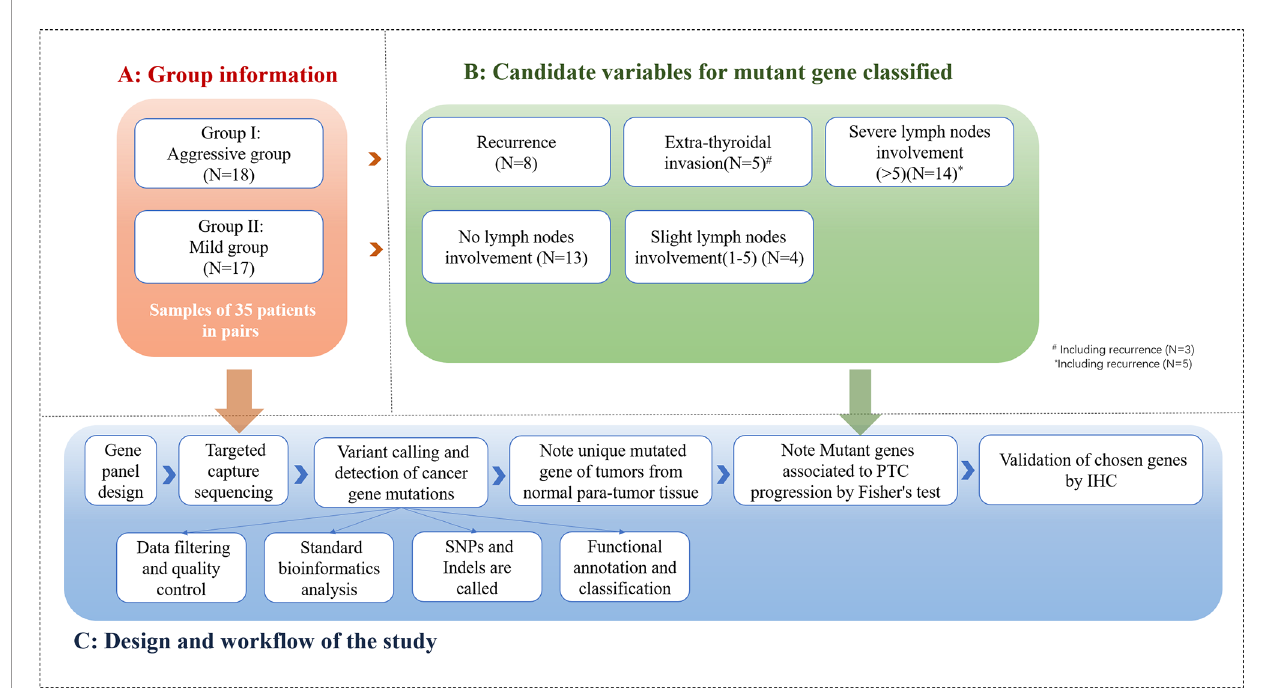
FIGURE 2 | Method and fl ow of the study (The cohort of 35 patients in study group was categorized into 2 groups: PTC group (n=18) and mild PTC group (n=17). Aggressive PTC contains 8 patients with recurrence, 5 patients with extra-thyroidal invasion, 14 patients with severe lymph nodes involvement; Mild PTC group contains 13 patients without lymph nodes involvement and 4 patients with 0-5 lymph nodes involvement. 70 samples from 35 paired of patients were taken into NGS and bio-information